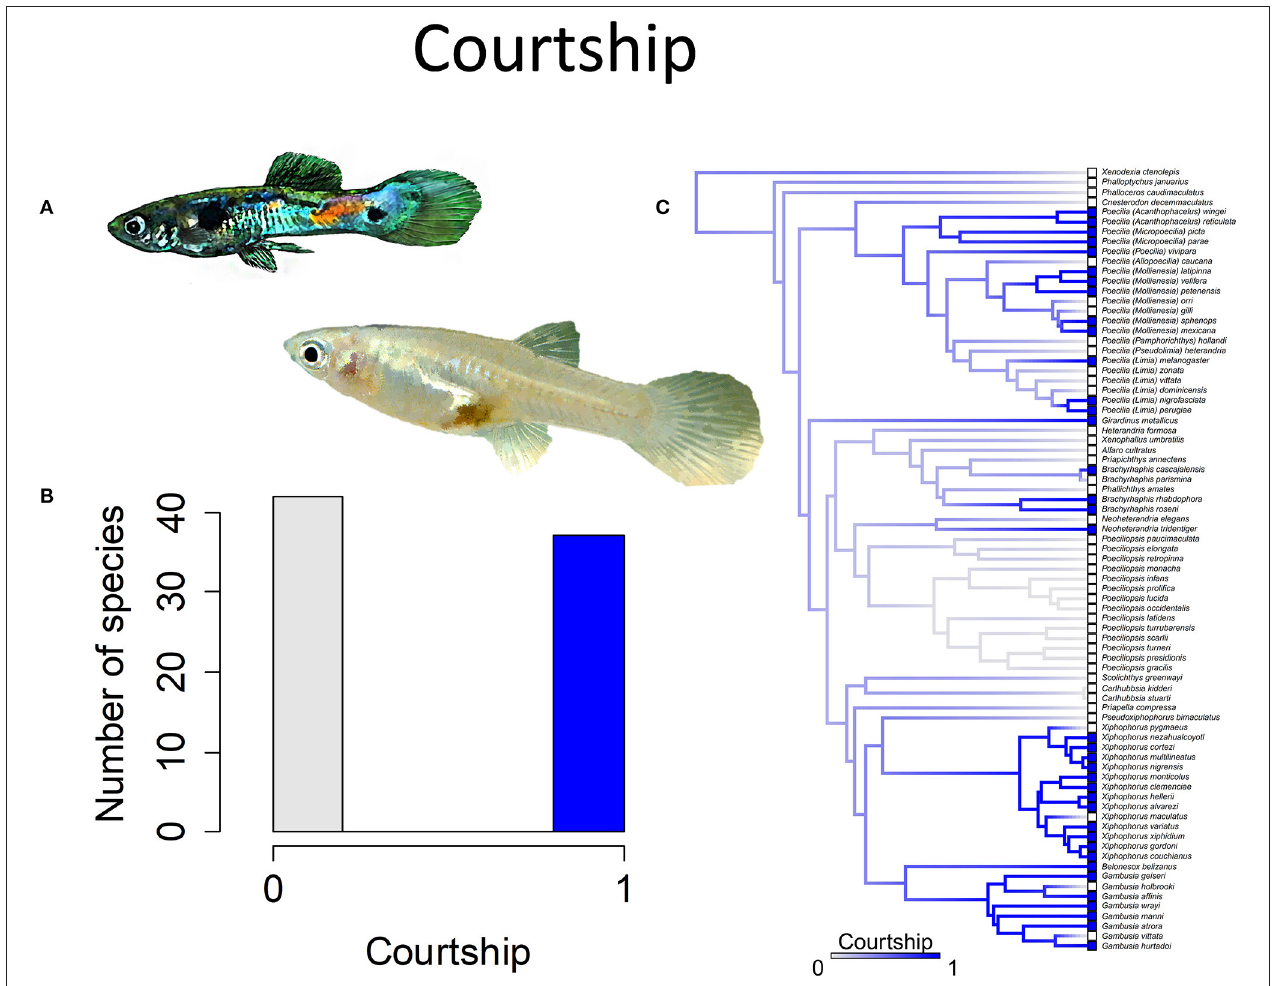
FIGURE 7 | Courtship in the family Poeciliidae involves males displaying for females by spreading their unpaired fins and is often accompanied by stereotypical movements such as a sigmoid posture; the alternative to courtship is coercive or sneak-chase mating. (A) A male guppy, Poecilia reticulata , displays for a female (pictured) to elicit cooperation during mating. (B) Frequency histogram of presence or absence of male courtship ( n = 79). (C) Ancestral state reconstruction of courtship as a binary character was performed using stochastic character mapping in the R package phytools. Branch colors represent posterior densities of edge states based on 1000 stochastic character maps of each reconstruction. The phylogeny tips depict a binary categorization of courtship (i.e., absence vs. presence). Figure redrawn after Furness et al. (2019). The most likely ancestral state of the family is the absence of courtship (Furness et al.,